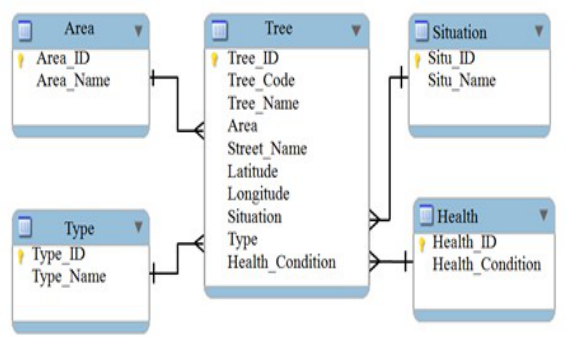
Figure 5. Sample database designed for the proposed